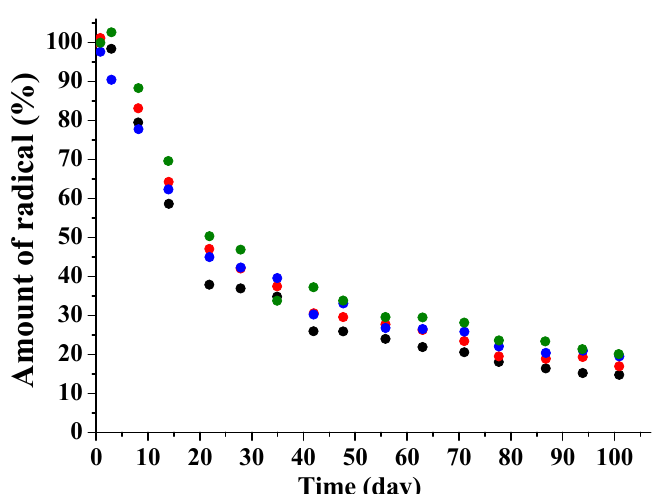
Figure 12. The kinetic curves of the radical’s decomposition inside PDLLA films in the presence and in the absence of AA in the outer liquid: systems “TEMPONE/PBS + AA” (black symbols), “sl-DCF/PBS + AA” (red symbols), “TEMPONE/PBS” (blue symbols), and “sl-DCF/PBS” (green symbols). Measurement errors are 10–12%.